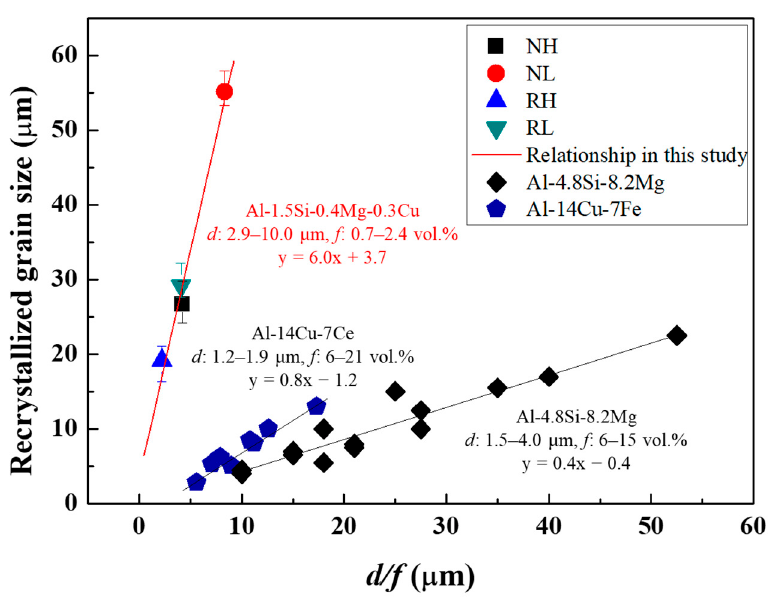
Figure 8. Dependence of the recrystallized grain size on d/f in the different Al alloys. Results for Al-4.8Si-8.2Mg and Al-14Cu-7Fe alloys were reported by Mikhaylovskaya, et al. [38].